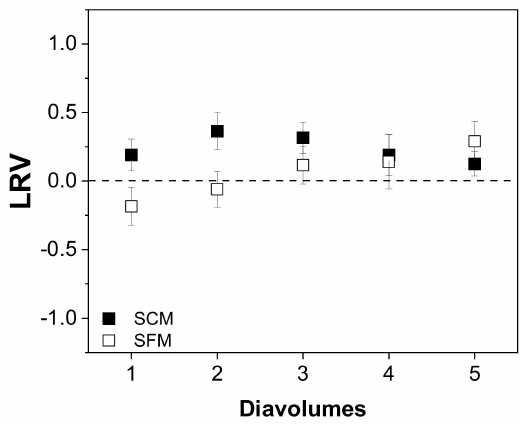
Figure 5. Relationship between the number of diavolumes and the infectious virus titer (TCID 50 ) during the purification of MV by UF/DF. Data are means ± SEM (n = 5) [37].